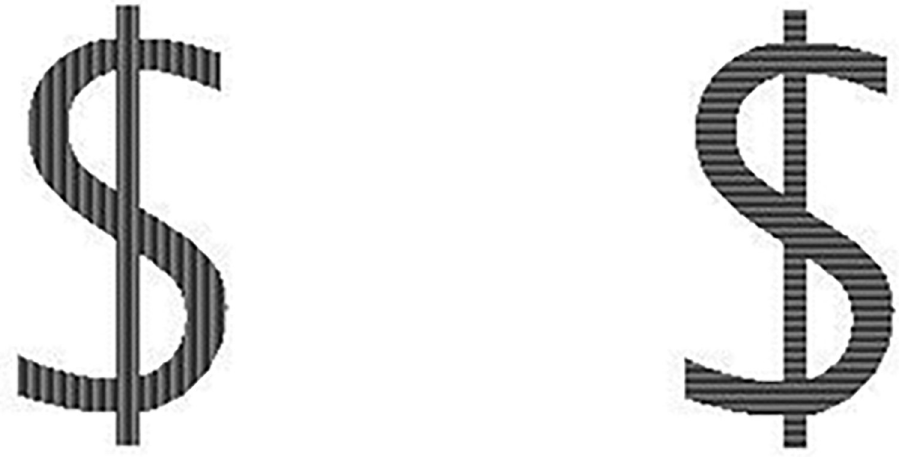
Fig 2. Larger example of stimuli with cue relevant for Task